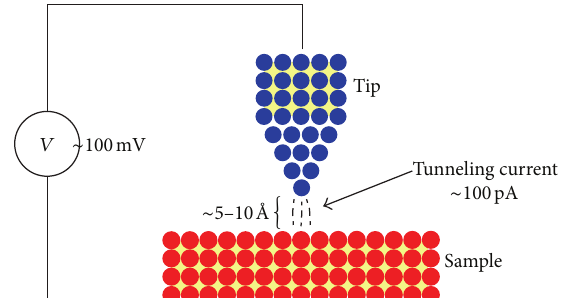
Figure 10: A schematic STM setup. When a tip is brought several angstroms away from a sample and a voltage are applied between them, a very small current flows—of order 10 −10 amperes—between the last atom of the tip and the sample. For comparison, a typical light bulb usually has a flowing current of order 1 ampere. Our tunneling current is roughly 10 billion times smaller. As we scan the tip over the surface, the rise and fall of the atomic landscape comprising the sample surface leads to changes in the current and hence to the STM’s ability to image the surface.